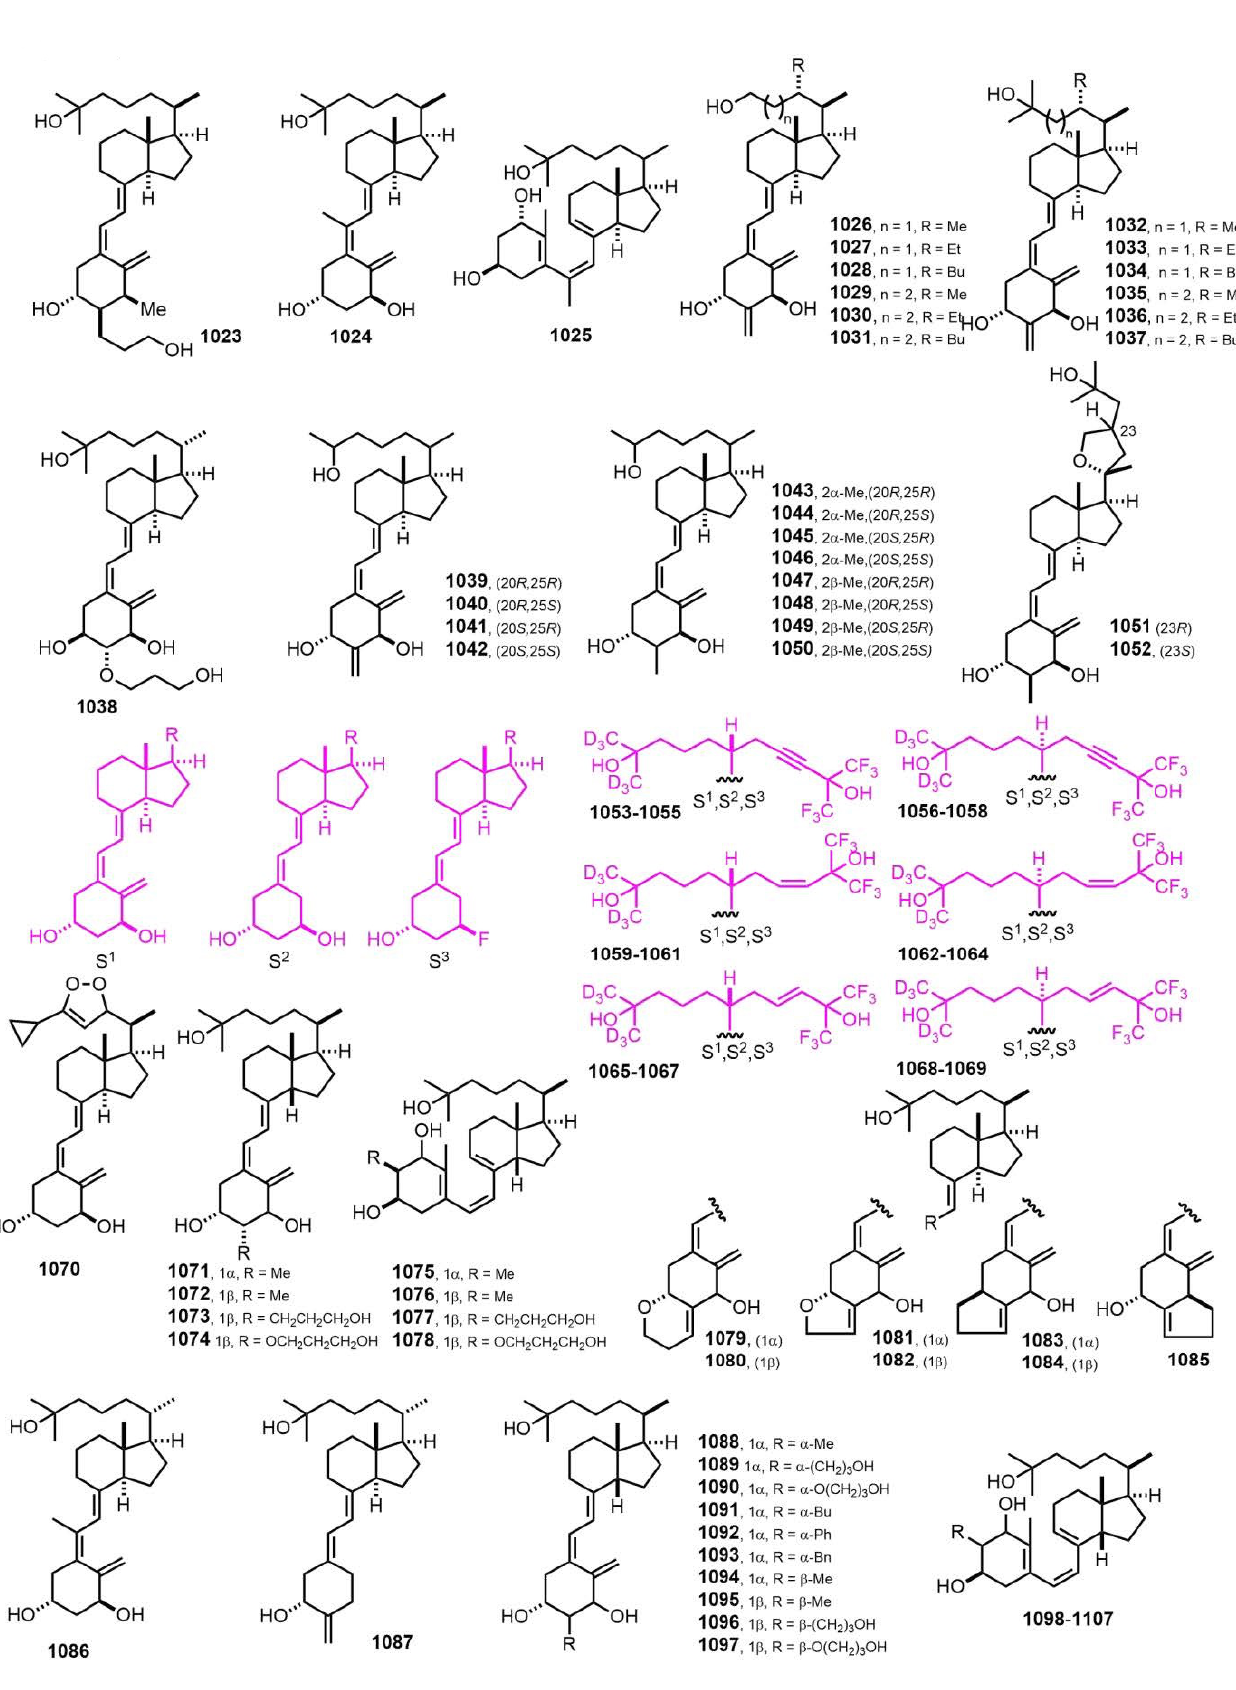
Figure 19. (2009-2010) [271 –